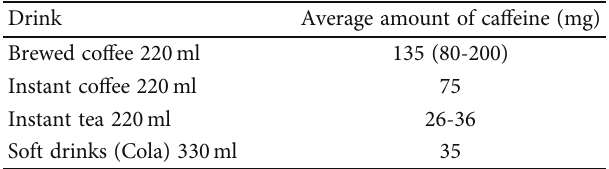
Table 7: Ca ff eine content of di ff erent beverages: adapted after [49].